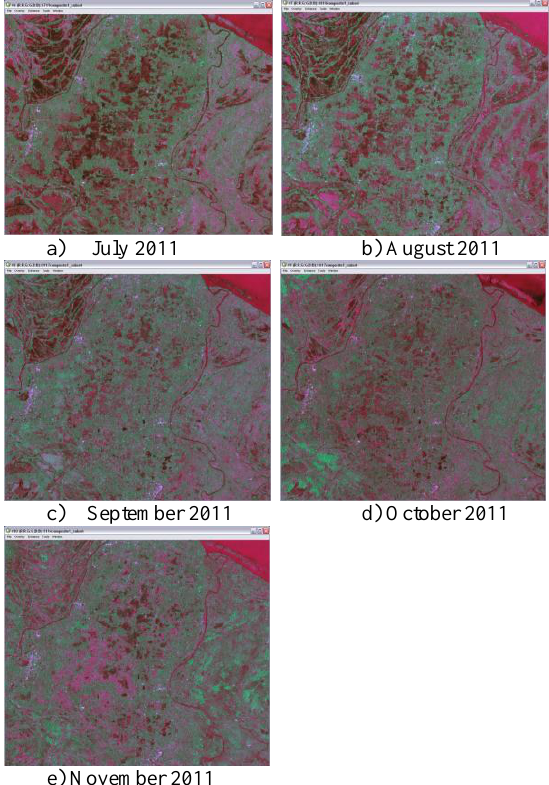
In the series of RGB color